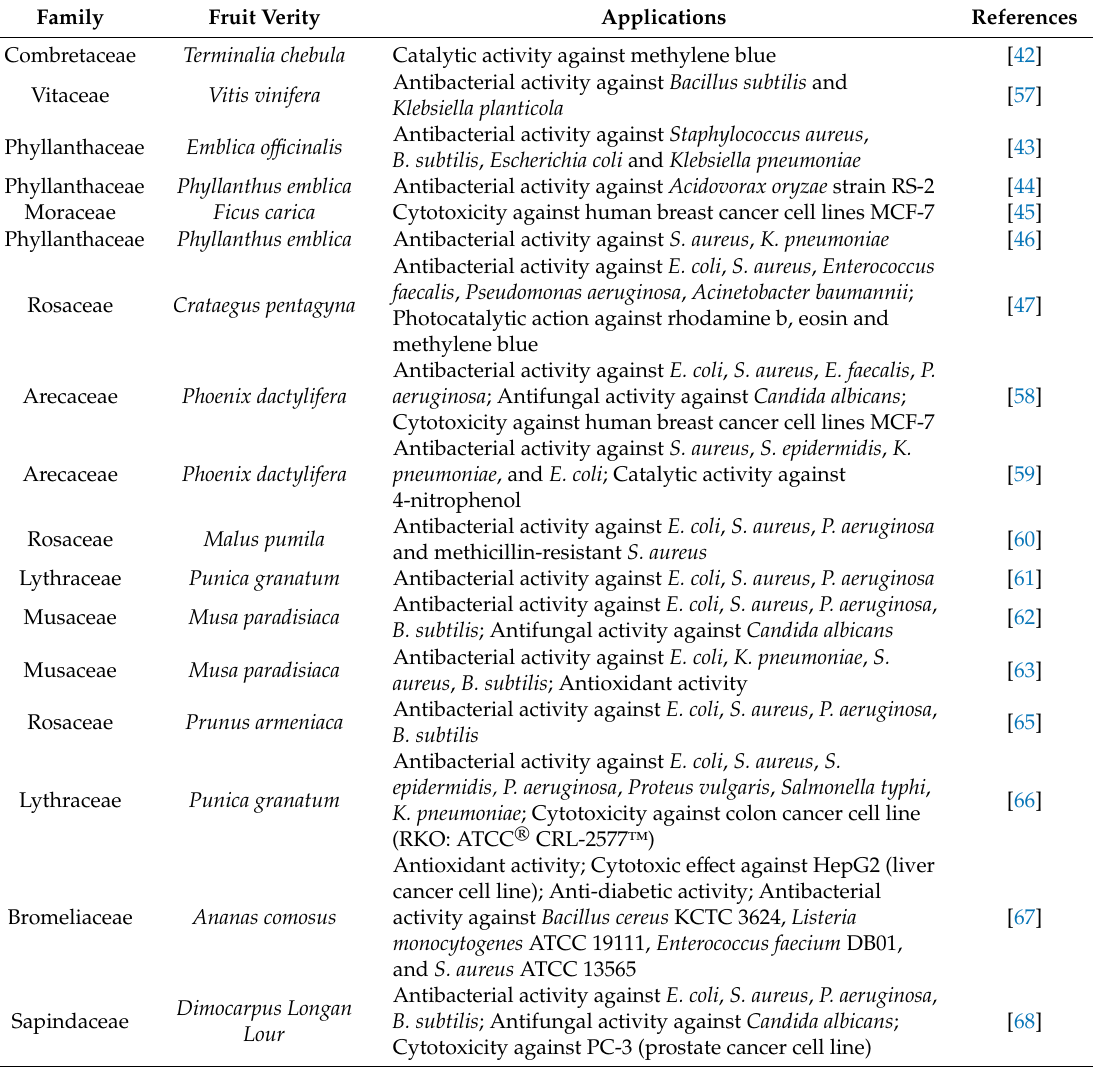
Table 5. Applications of silver NPs synthesized from various fruit